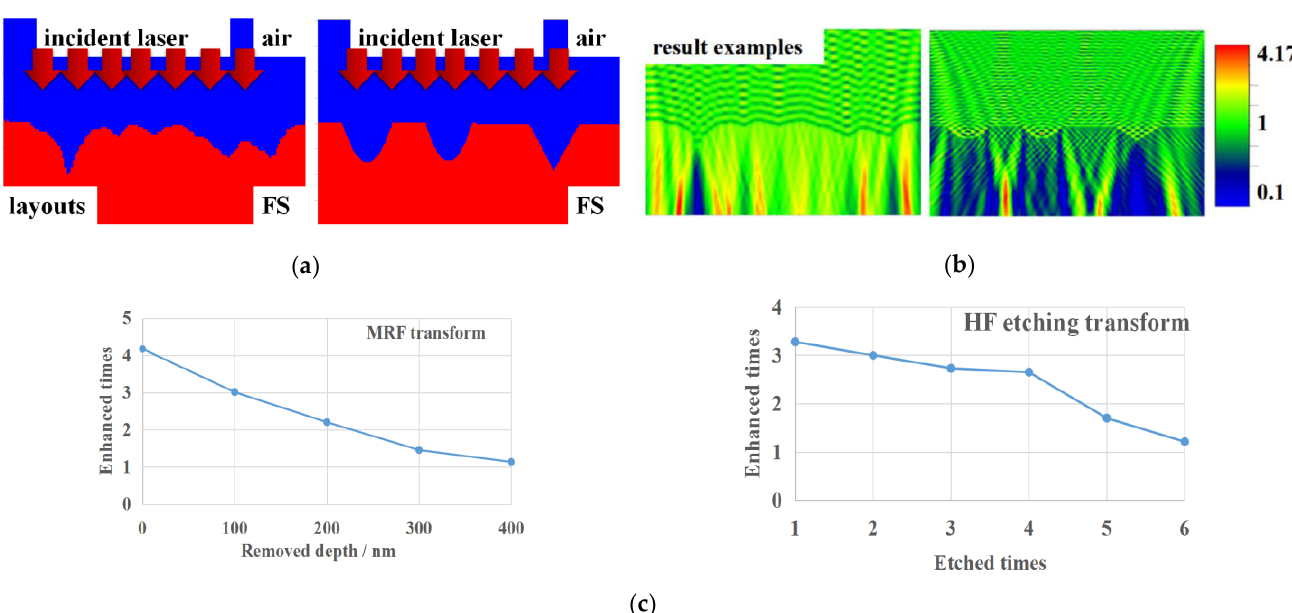
Figure 6. FDTD simulation of scratches; ( a ) model layouts; ( b ) simulation results; ( c ) light field enhancement evolution trends.